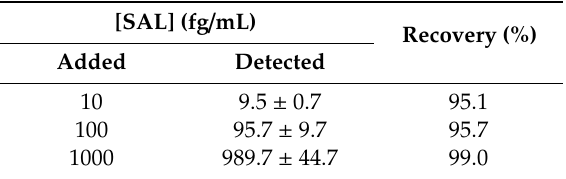
Table 3. The practical measurement of SAL concentration prepared in 1000-times-diluted porcine serum samples. Each concentration was measured by four